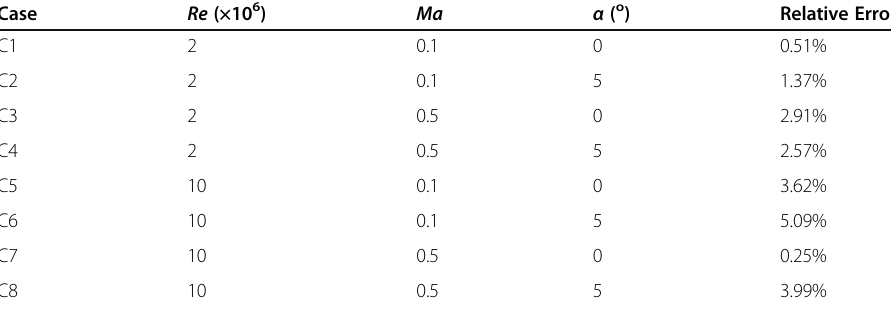
Table 6 The relative error of C d of the eight boundary point cases in the test space Case Re (×10 6